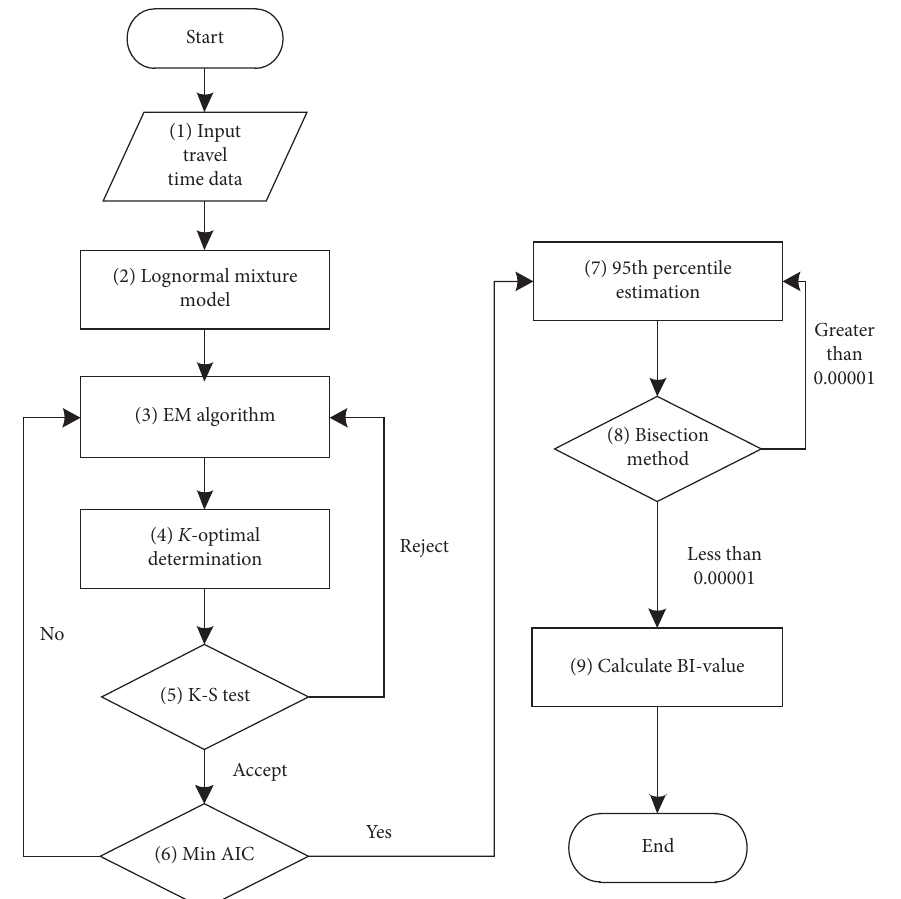
Figure 2: Framework for estimating O-D-based TTR.